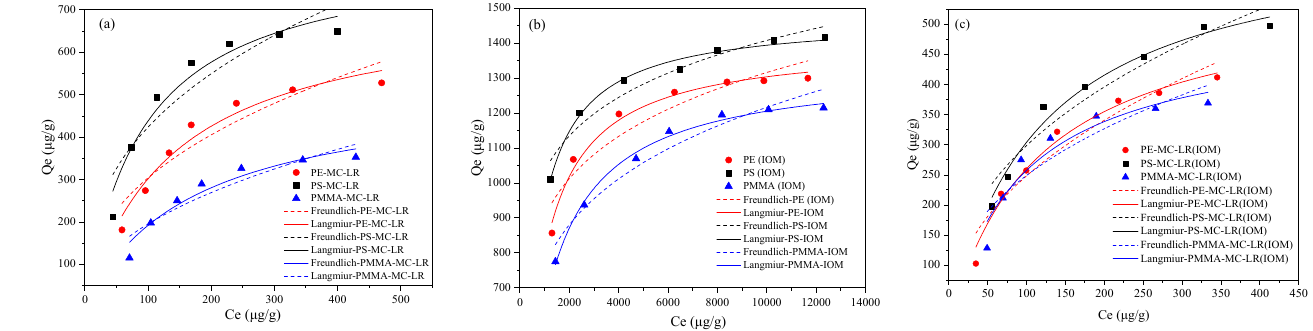
Figure 2. Isothermal adsorption model fitting curves for MC-LR ( a ), IOM ( b ), and MC-LR adsorption in the presence of IOM ( c ) on PE, PS, and PMMA.